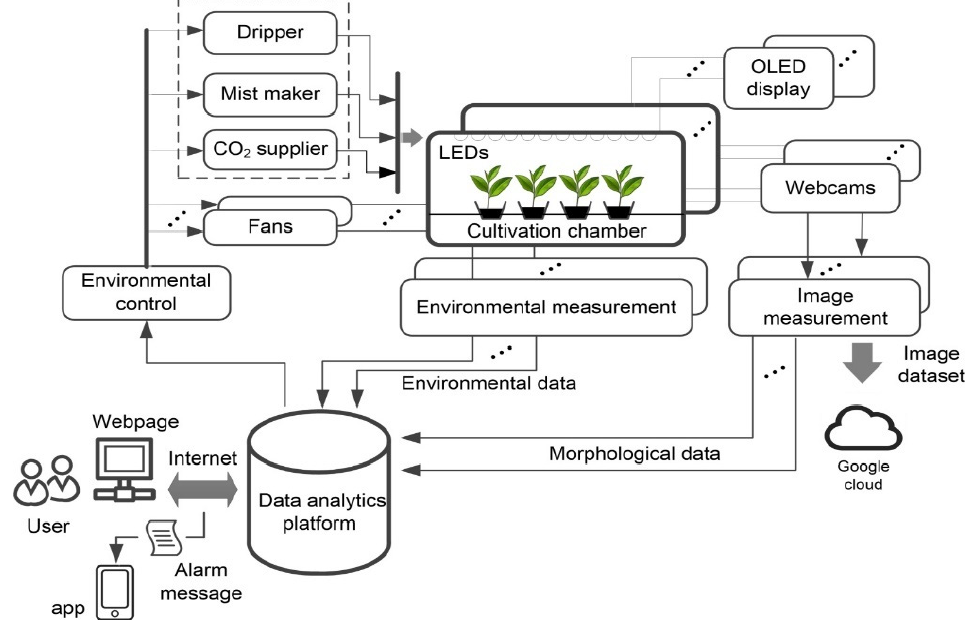
Figure 1. Indoor cultivation framework with artificial Internet-of-things (AIoT). Each cultivation chamber is equipped with two webcams (one is installed and fixed on the side bracket of the cultivation zone, and the other is installed and fixed on the front partition of the cultivation zone), six LED light tubes, an environmental sensing module (including OLED display interface), and fans. The environmental data and the tea plant image are, respectively, transmitted to the data analysis platform by the environmental measurement system and the image measurement system via the Internet for storage. The image datasets will also be transmitted to Google Cloud to be stored. The dashed frame represents the cultivation facilities, including dripper, mist maker, and CO 2 supplier. Environmental control systems are used to drive these facilities, as well as fans in each cultivation zone, which are utilised to maintain certain levels of environmental parameters in the cultivation